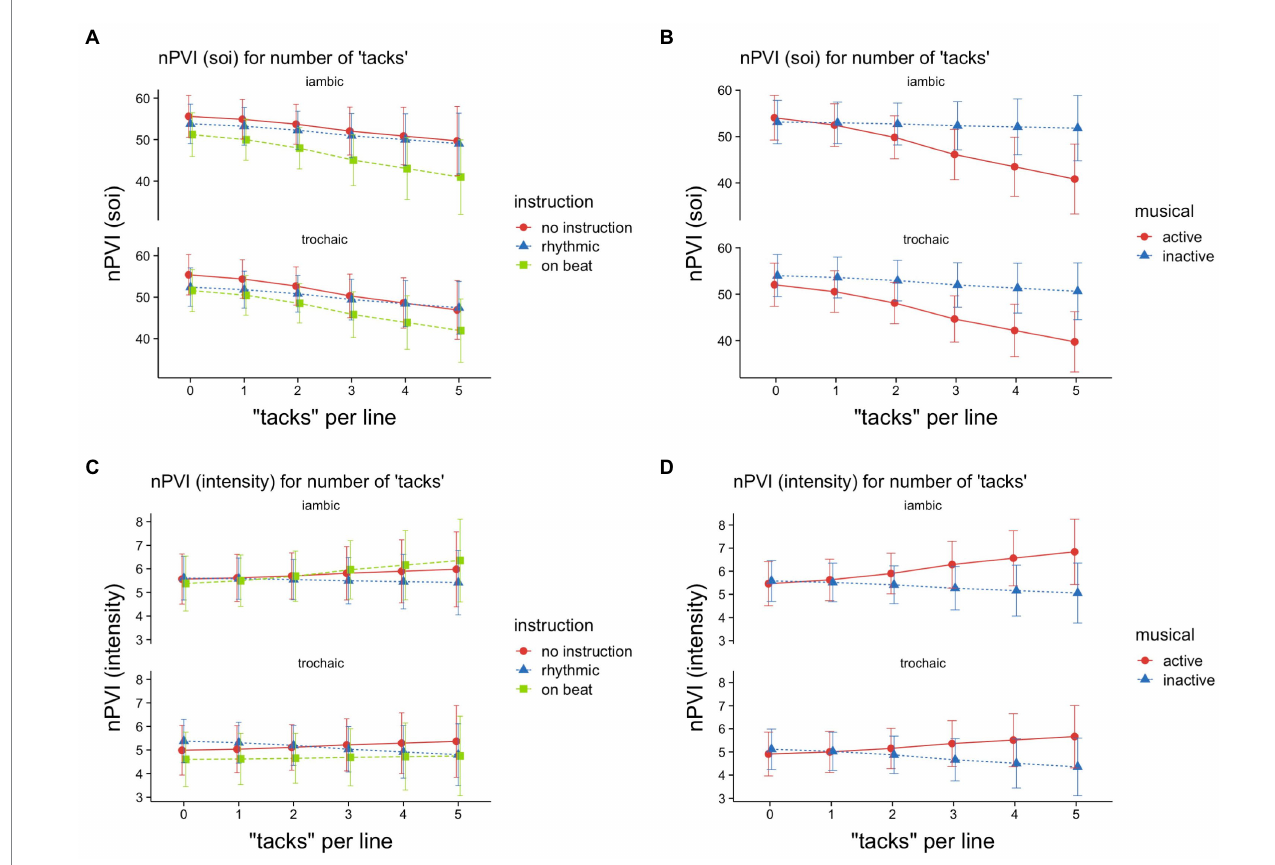
FIGURE 4 Illustration of the analysis of variable instruction on the line level for two models: including variable instruction (A,C) vs. including the interaction of instruction and musical (B,D) . SOI-based nPVIs (A,B) and intensity-based nPVIs (C,D) , as a function of meter (iambic vs. trochaic), and either instruction (no instruction vs. rhythmic vs. on beat; A,C ) or musical activity (active vs. not active; B,D ), and tacks per line (the number of tacks in a line, ranging from low = 0 to high = 5; B,D ). The whiskers depict 95%